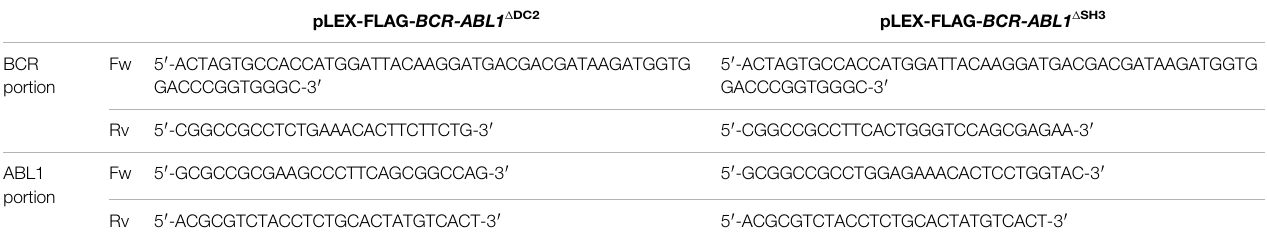
TABLE 1 | BCR and ABL1 primer sequences to generate Δ DC2 and Δ SH3 FLAG-BCR-ABL1 deletion constructs. pLEX-FLAG- BCR-ABL1 Δ